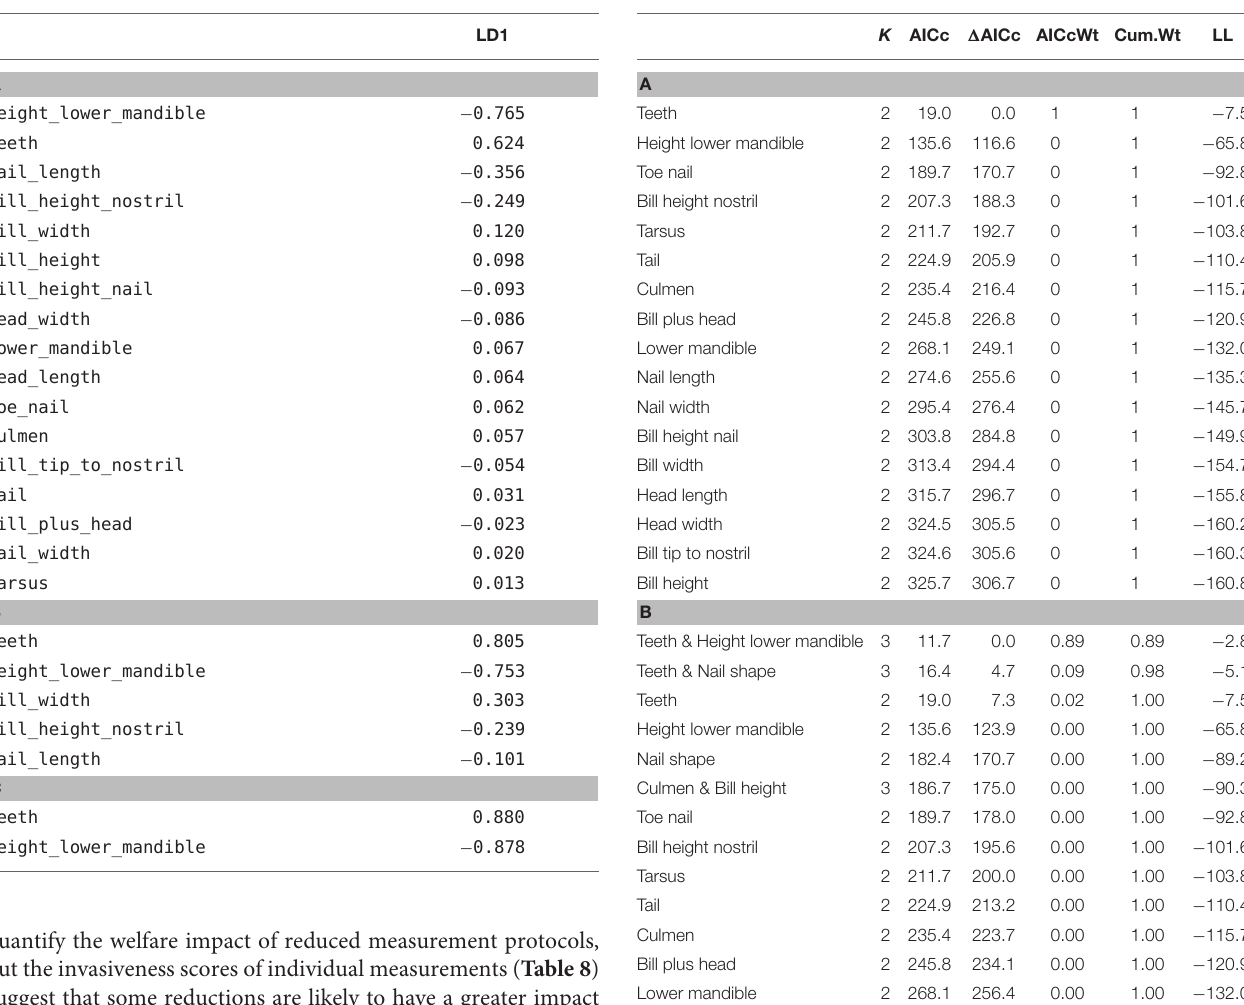
TABLE 6 | Linear discriminant coefficients for model based on all 17 (A) , five (B) and two variables (C) .